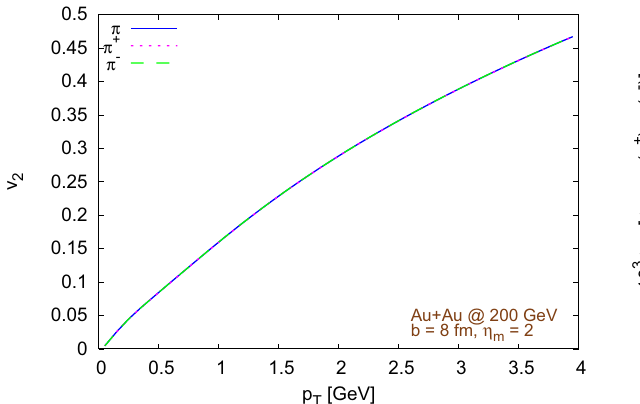
tive pions ( × 10 3 ), computed by using either the Maxwell equations or √ s NN = 200GeV thevorticity.BothplotsreferstoAu+Aucollisionsat with b = 8fm and tilted initial energy density distribution ( η m = 2)